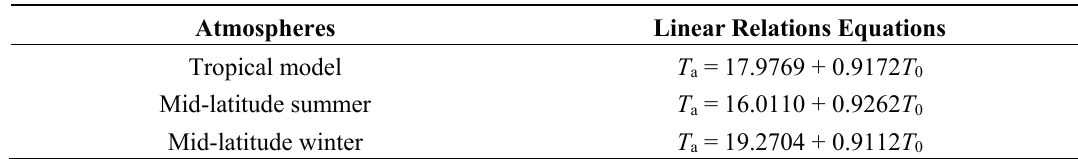
Table 3. Linear relations for the approximation of effective mean atmospheric temperature ( T a ) from the near surface air temperature ( T 0 )